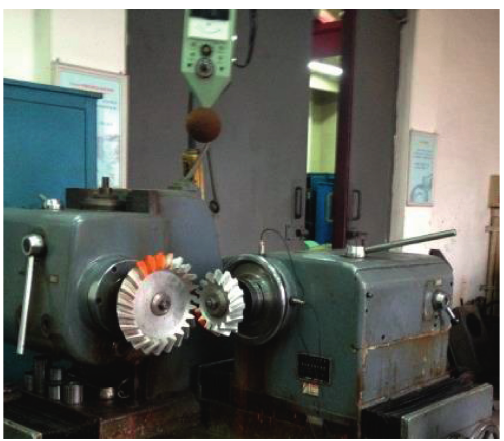
Figure 10: Photo in machining.